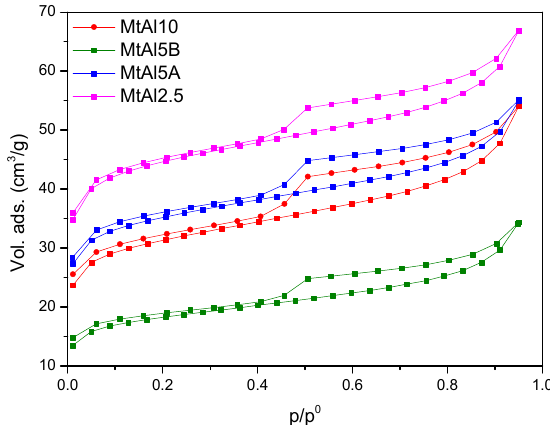
Figure 4. Nitrogen adsorption–desorption isotherms of the pillared solids.